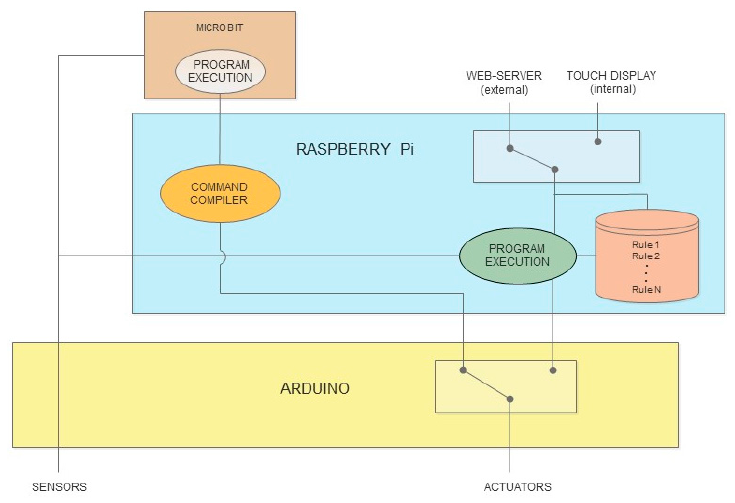
Figure 7. Illustration of the control of the GrowBot, and sensor and actuator communication flow through the Arduino to the Raspberry Pi.